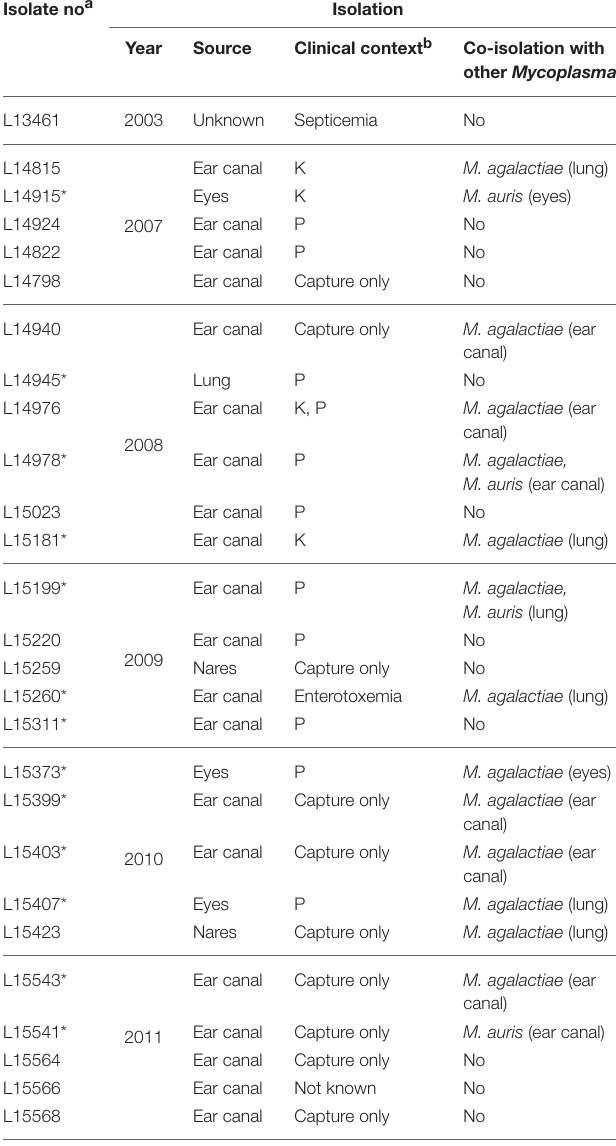
TABLE 1 | M. feriruminatoris sp. nov. isolates from French Alpine ibex included in this study. Isolate no